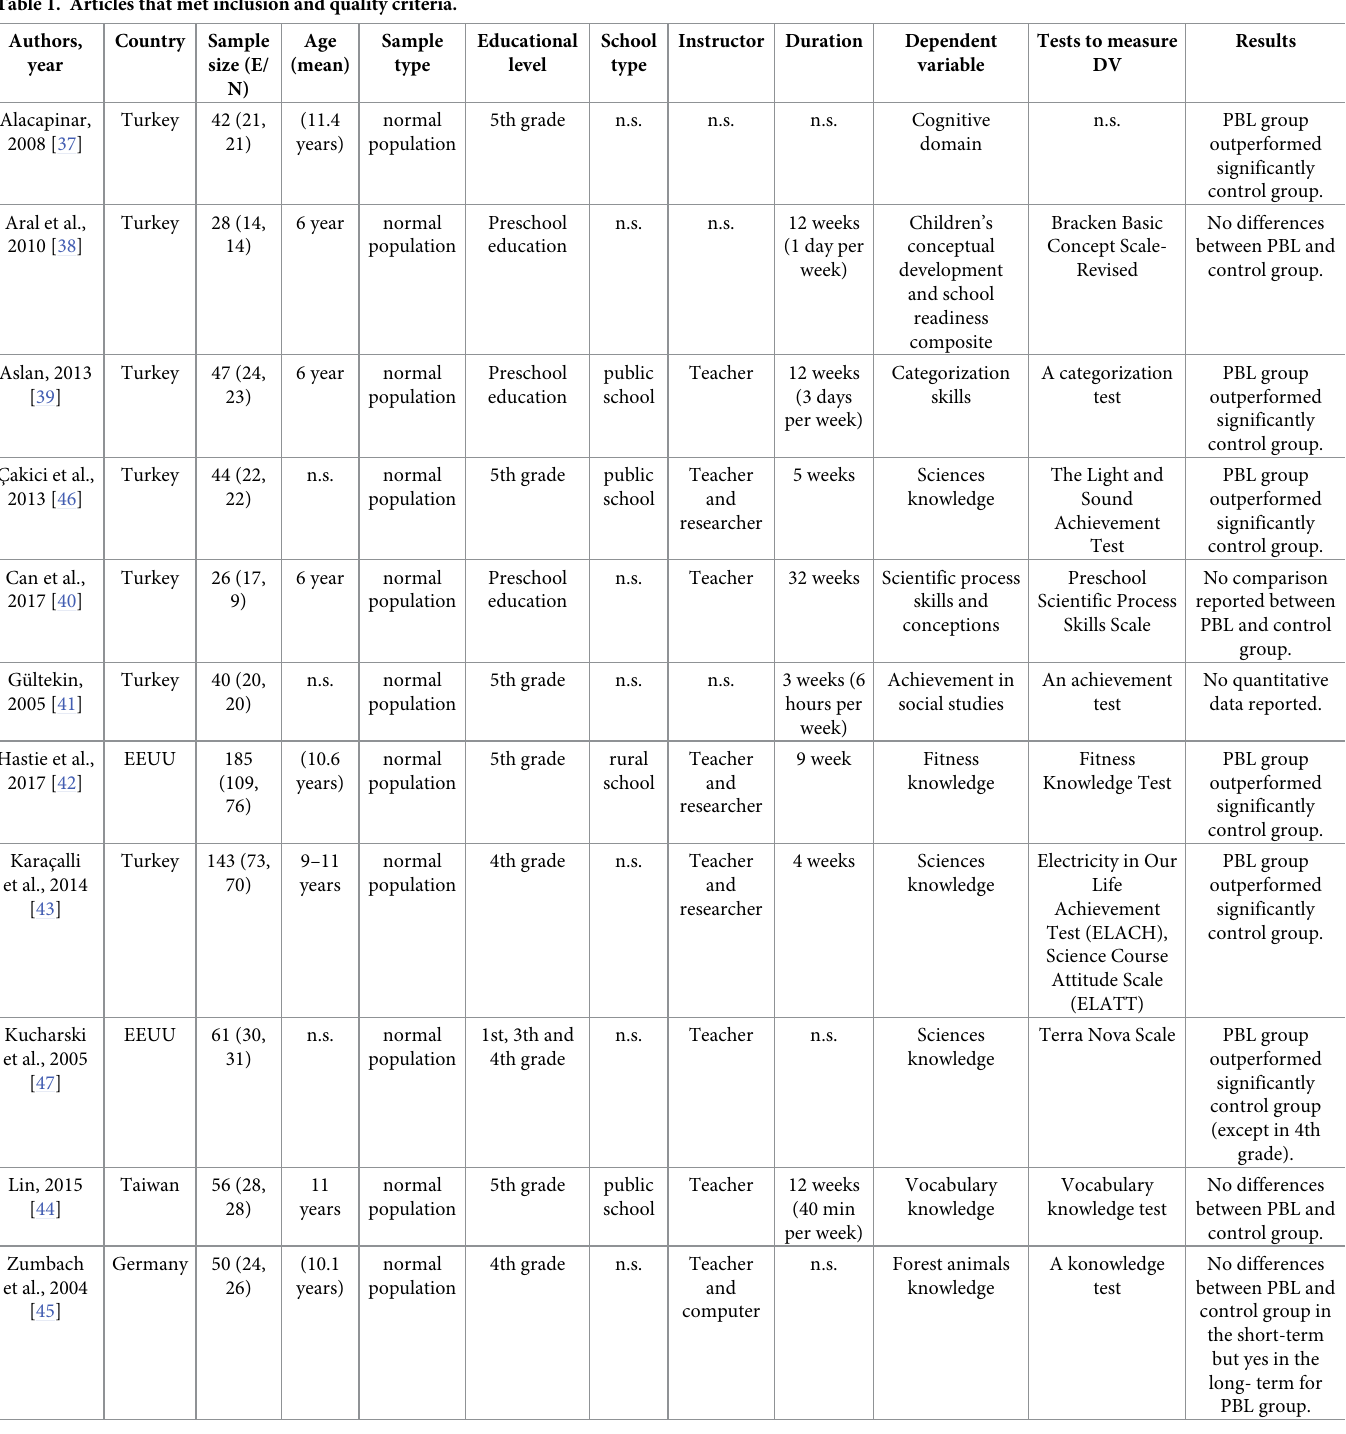
Table 1. Articles that met inclusion and quality